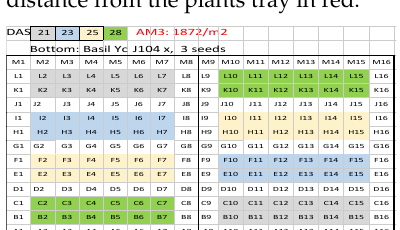
The diagram below represents the plant positions for each layer of AM3.